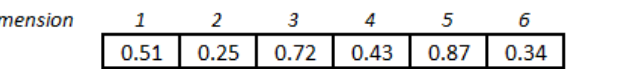
Figure 6. Encoding example of the postman delivery routing problem with six customers and two vehicles.